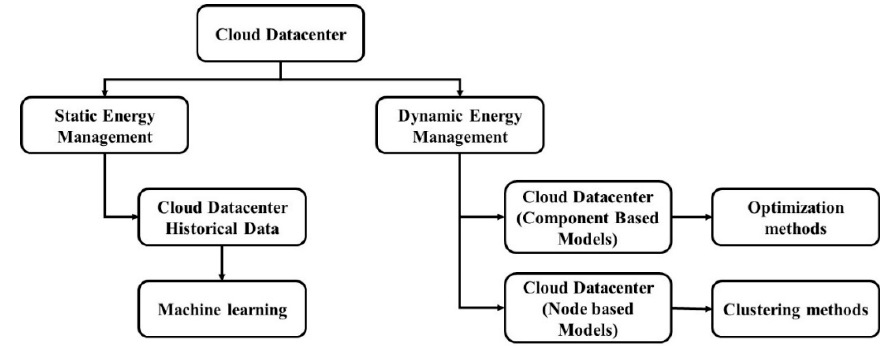
Figure 1. Proposed taxonomy for the energy efficiency methods in the